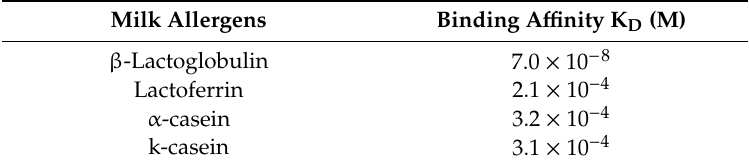
Table 1. Selectivity of the developed BLG nanoMIPs sensor based on the binding a ffi nities for BLG, LF, α -casein,